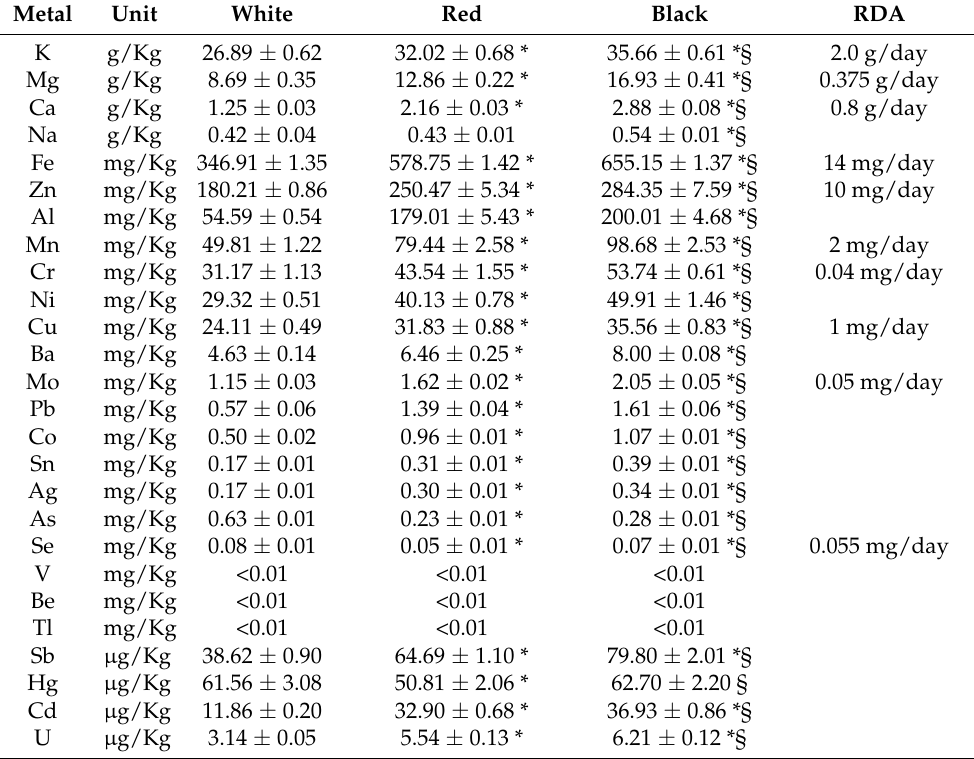
Table 4. Elements content in sorghum varieties. Abbreviation: Recommended Daily dose